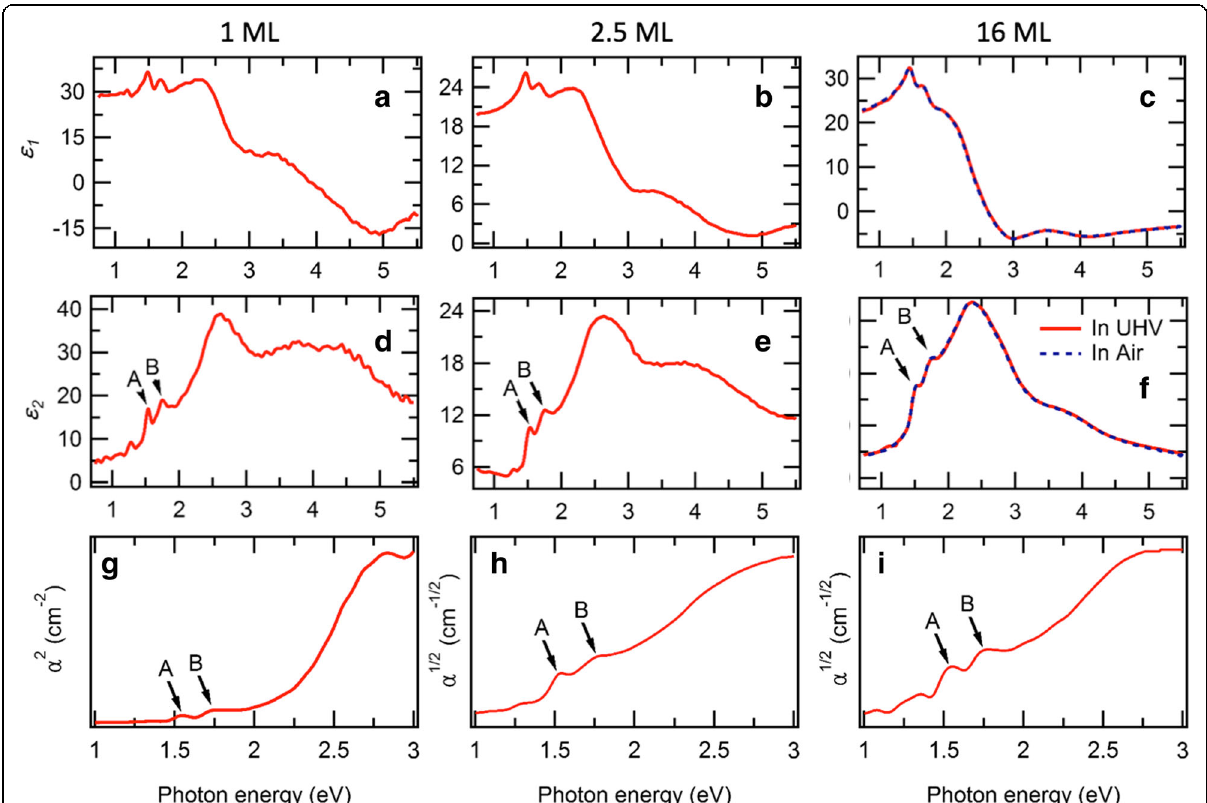
Fig. 2 Optical spectra of the 1, 2.5, and 16 ML of MoSe 2 films. a – c Real part of the dielectric function ( ε 1 ). d – f Imaginary part of the dielectric function ( ε 2 ). g – i Absorption coefficient ( α ) for the case of direct band gap ( g ) and indirect band gap ( h, i ). The peaks labeled A and B in d – i correspond to the direct excitonic transition at the K point in momentum space. All the measurements are performed in UHV at room temperature, except the 16-ML MoSe 2 film measured both in UHV and air